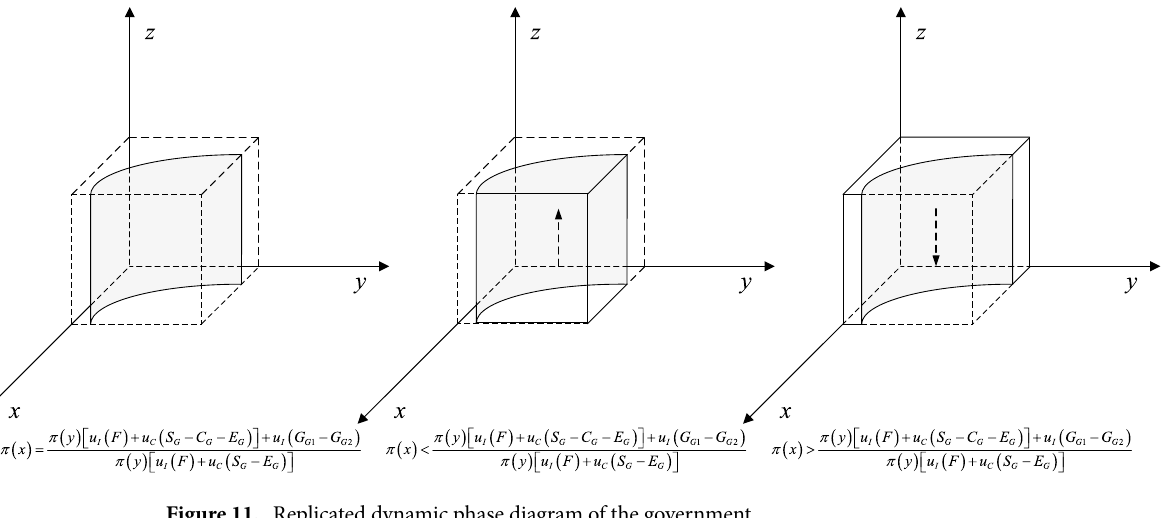
Figure 11. Replicated dynamic phase diagram of the